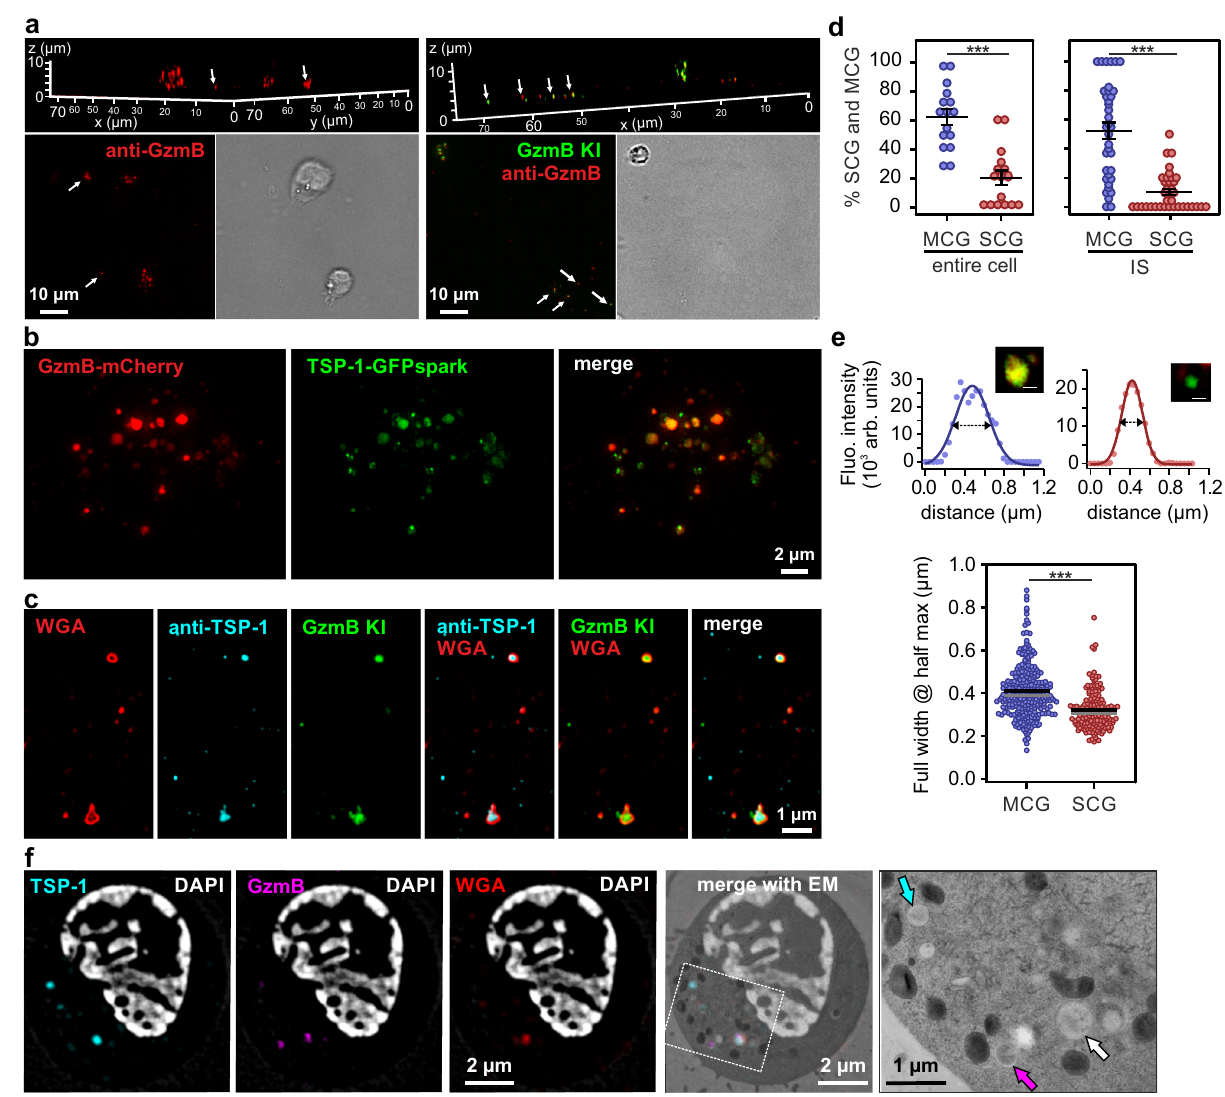
Fig. 5 Multi core granules contain supramolecular attack particles (SMAPs). a SIM images of WT (left) and GzmB KI (right) cells on supported lipid bilayers (SLB) represented in 3D (top) and 2D (bottom). Cells were stimulated on anti-CD3 antibody coated lipids for 90 min and stained with anti-GzmB (red) antibody after fi xation. White arrows point to secreted SMAPs. N mouse = 1; n images = 3 and 6 for WT and GzmB KI, respectively. b SIM images of one resting WT CTL expressing GzmB-mCherry and Thrombospondin 1 (TSP-1)-GFPspark seeded on poly-ornithine coated coverslip. N mouse = 1; n cells = 14. c SIM images of secreted SMAPs on SLB from GzmB KI CTLs pre-incubated with wheat germ agglutinin (WGA)-647 to label intracellular, glycoprotein-rich compartments. Secreted SMAPs were stained with anti-TSP-1 antibody. N mouse = 1, n images = 16. d Analysis of SCG and MCG percentage in resting cells